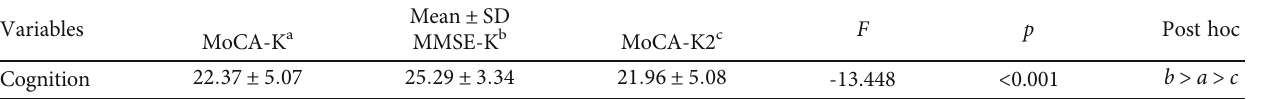
Table 4: Comparison of three clinical measurement tools for the cognitive impairments ( N = 185 ).